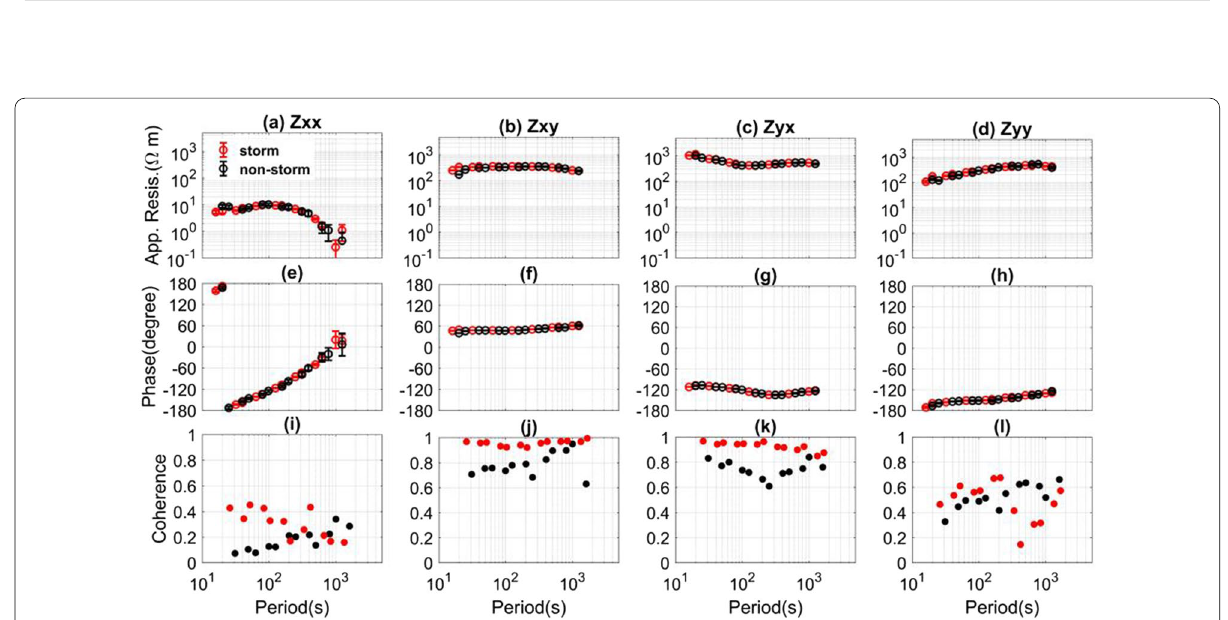
Fig. 6 MT sounding curves and coherence distributions during the storm and non-storm days using the data observed at site 163. The black color indicates the results calculated by the non-storm data observed from 00:00 on November 1 to 00:00 on November 4; the red color indicates the results calculated by storm data observed from 06:00 on October 29 to 06:00 on October 31. a – d Show the apparent resistivity. e – h Show the impedance phase. i – l Show the distribution of coherence. The horizontal axis denotes the period in